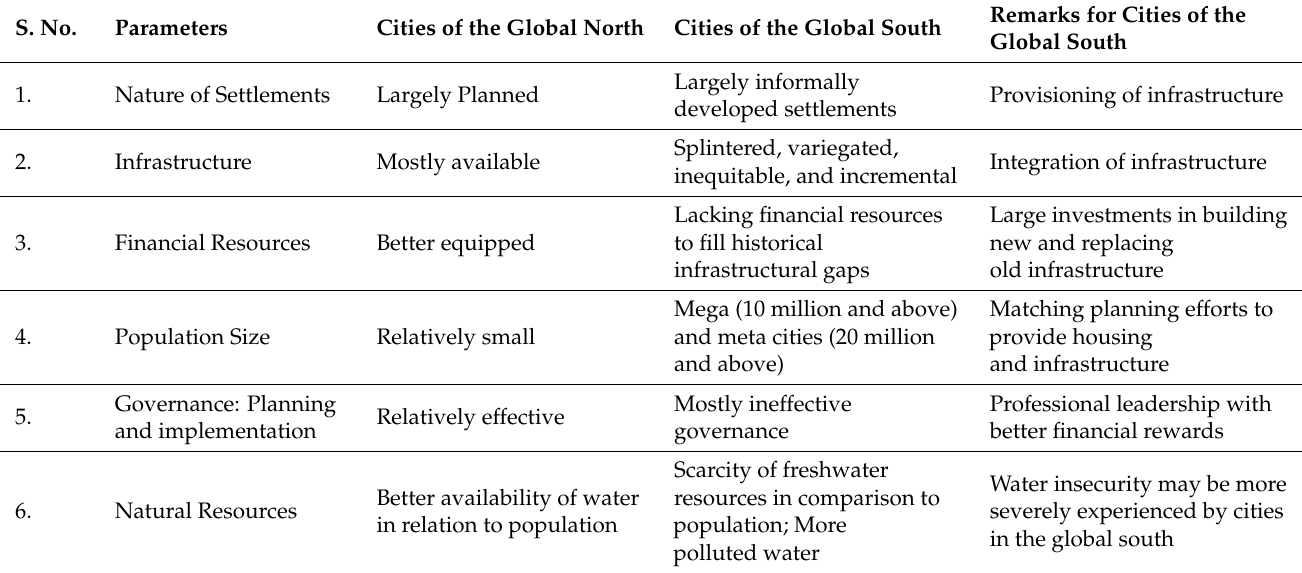
Figure 3. Predominant Ideas on Water Sensitive Planning [6,8,12,13,15,56,57,58,59] Table 1. WSP: Critical differences between Cities of the Global North and